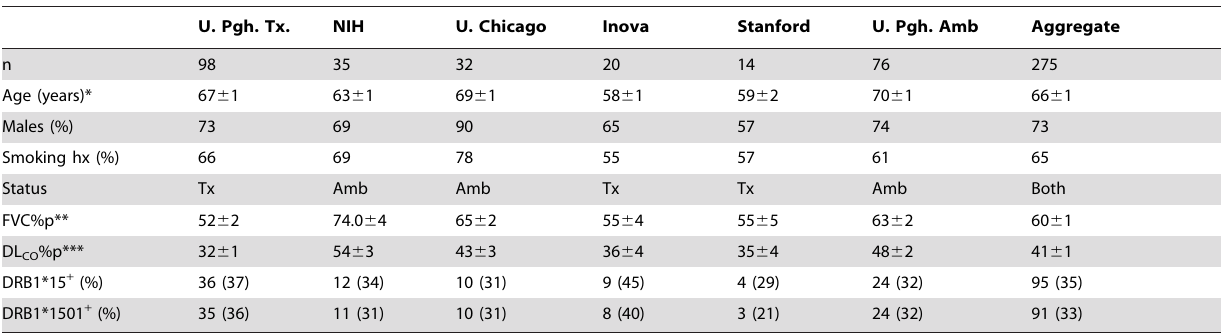
Table 1. IPF Subject Characteristics.